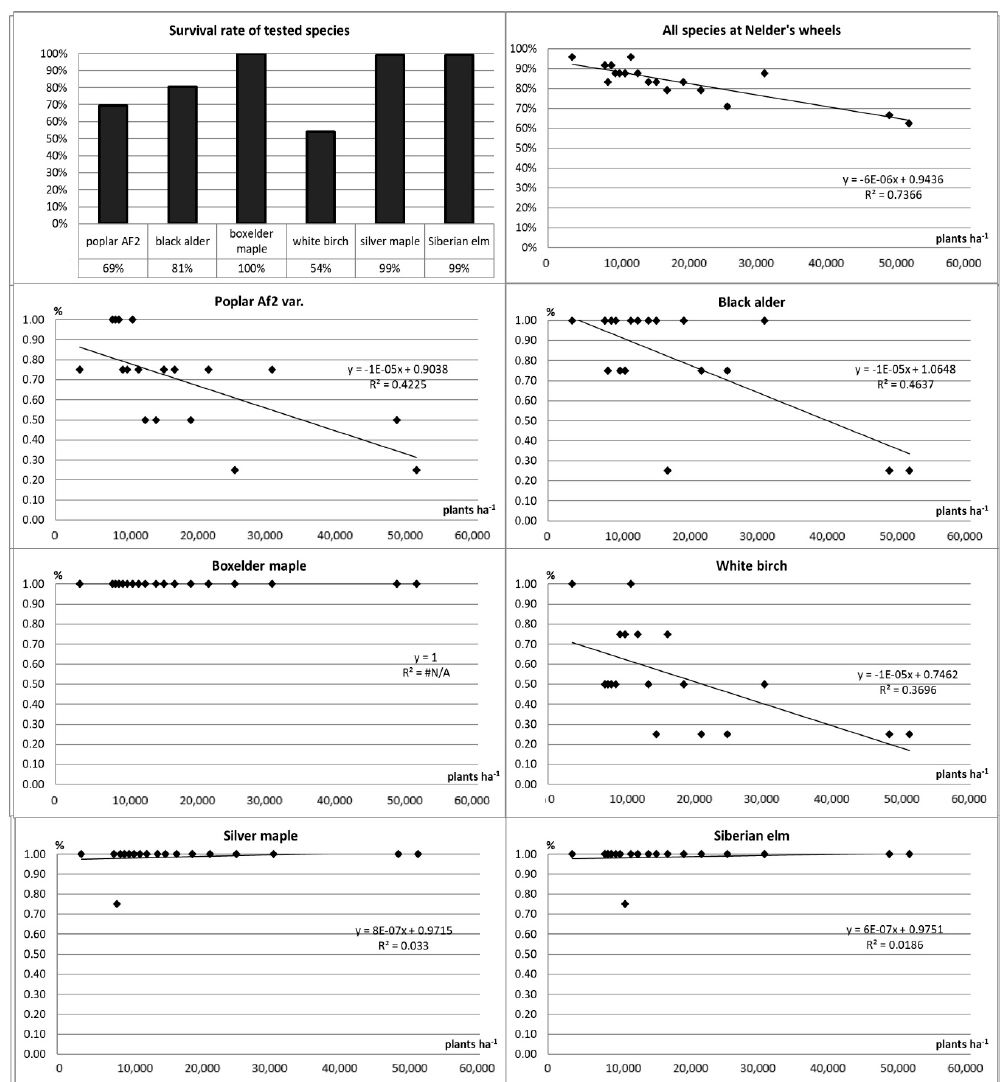
Figure 9. Survival rate after 7 years for different species and different planting densities.